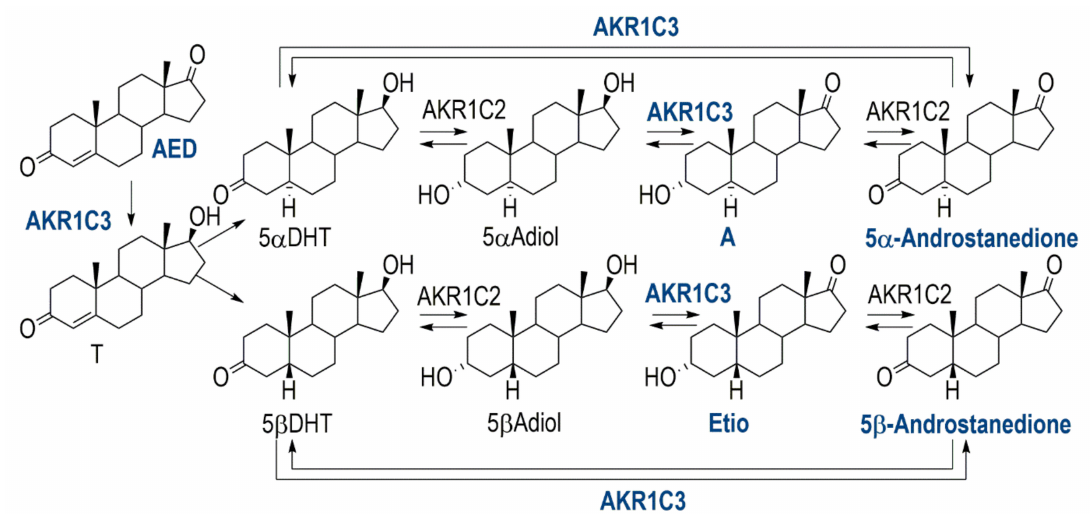
Figure 1. Metabolism of endogenous anabolic androgenic steroids (EAAS); blue and bold: substrates and enzymes used in this